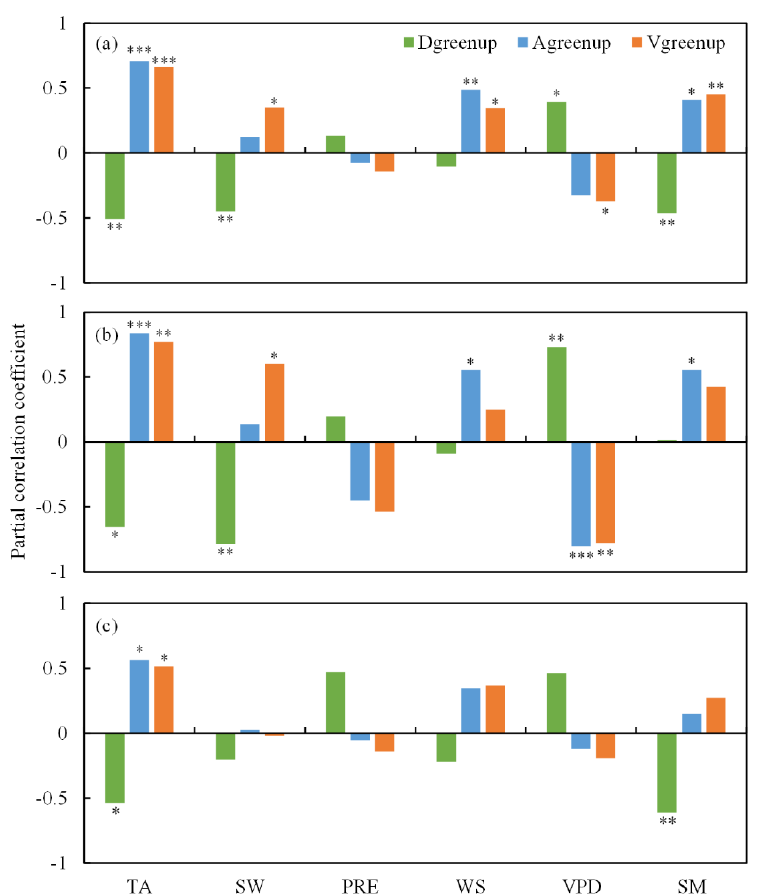
Figure 4. The partial correlation coefficients between spring climatic factors and Dgreenup, Agreenup, and Vgreenup. ( a ) The partial correlation coefficients across all sites in both Europe and North America; ( b ) the partial correlation coefficients across all sites in Europe; ( c ) the partial correlation coefficients across all sites in North America. TA, SW, PRE, WS, VPD, and SM represent temperature, shortwave radiation, precipitation, wind speed, vapor pressure deficit, and soil moisture, respectively. *, ** and *** indicate significant correlation at p < 0.05, 0.01 and 0.001 levels,